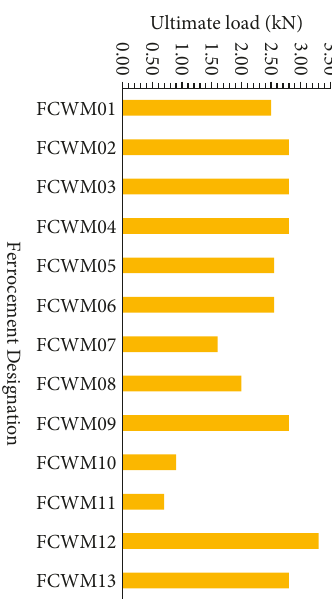
Figure 2: Ultimate load for different steel slag replacement and volume fraction of weld mesh ferrocement laminates.